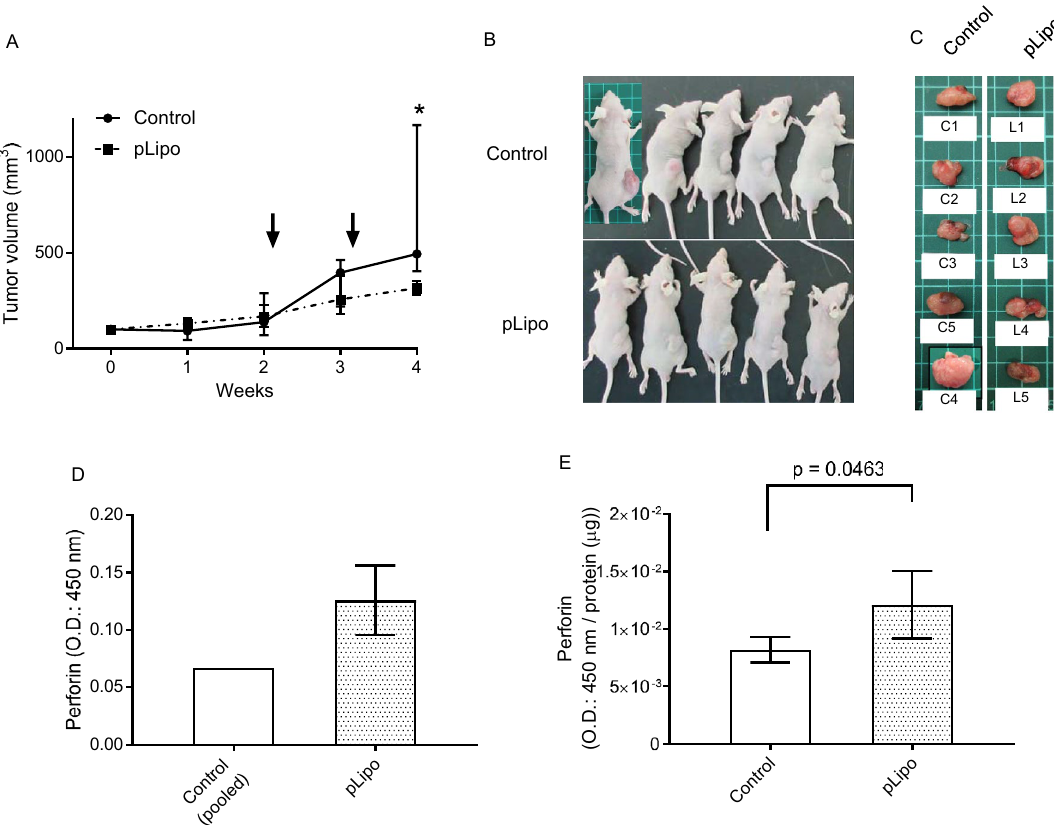
Figure 5. Anti-tumor effect of liposomes encapsulating PSA promoter-driven perforin expression vector in vivo. ( A ) pLipo were administrated to male nude mice bearing 22Rv1DR-derived tumor xenograft via tail vein (control: PBS, pLipo: 50.4 μg of perforin expression vector/injection). Tumor volume was measured once a week. Arrow heads indicate time when agents were injected. ( B ) Images of mice just after sacrifice. One mouse in control group was sacrificed 2 days before the planned date due to ethical reason of having developed a huge tumor. Data shown are median with range from five mice in each time point. Statistical significance was calculated using Mann–Whitney U test. *p = 0.0079 vs control at week 4. ( C ) All harvested tumors were imaged. ( D ) and ( E ) Perforin expression in serum ( D ) and lysed tumor ( E ) was measured by ELISA 24 h after injection of pLipo. The amount of intratumor perforin expression was standardized by the concentration of the lysed